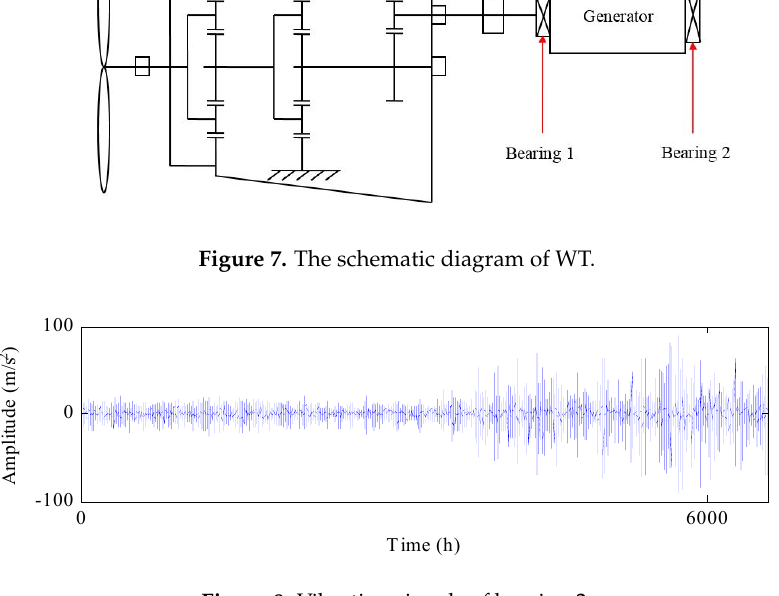
Figure 8. Vibration signals of bearing 2.